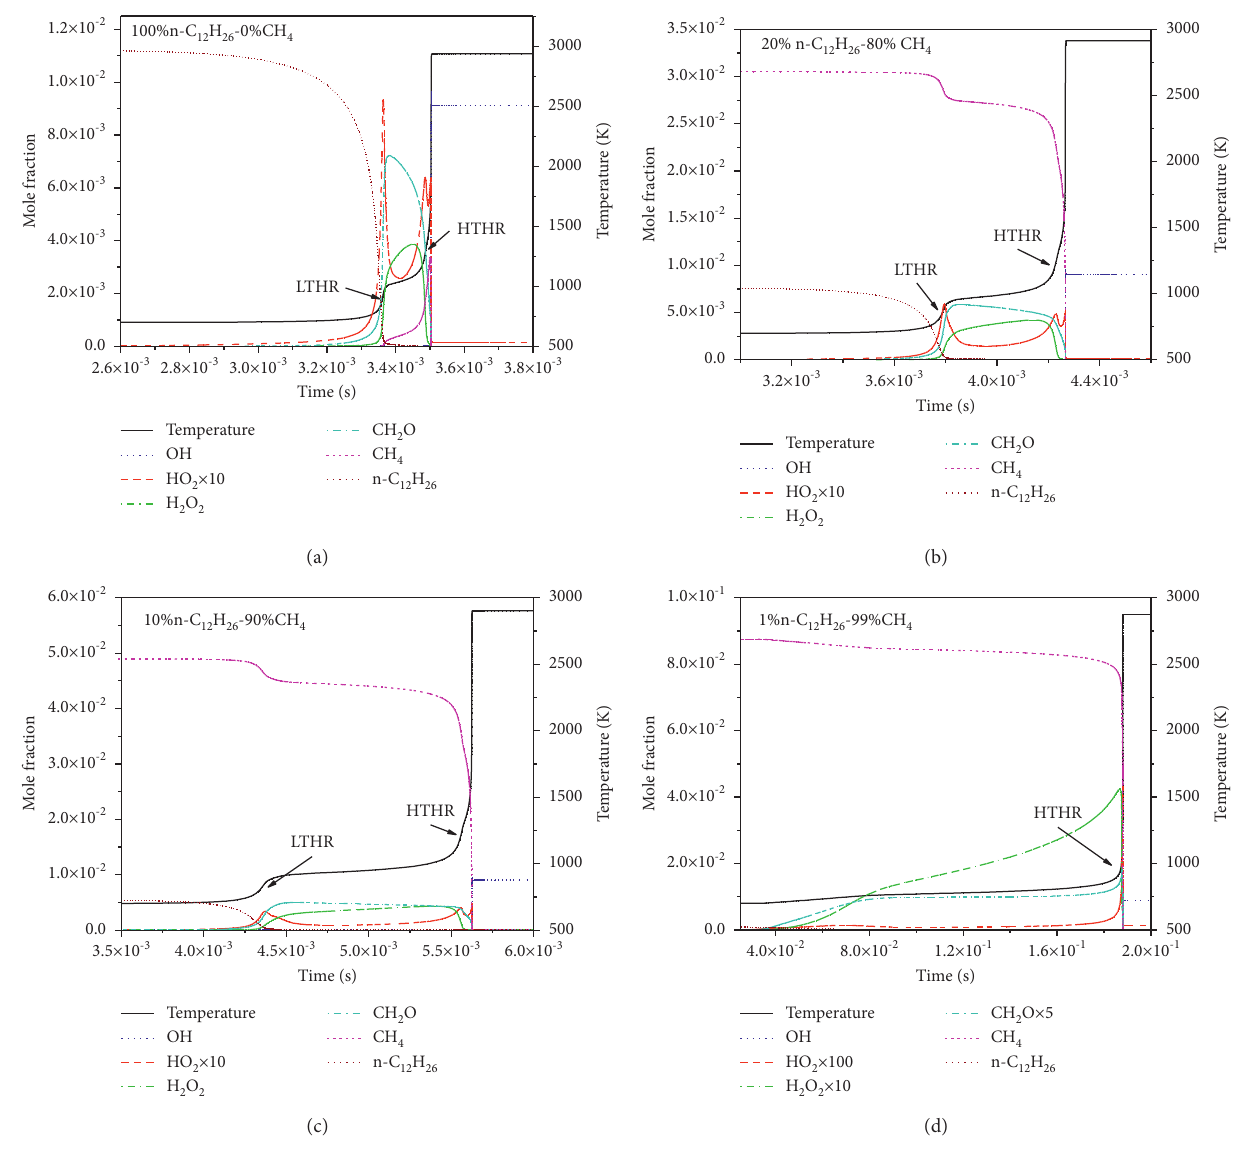
Figure 11: Species evolution of different methane-n-dodecane mixing ratios at ϕ